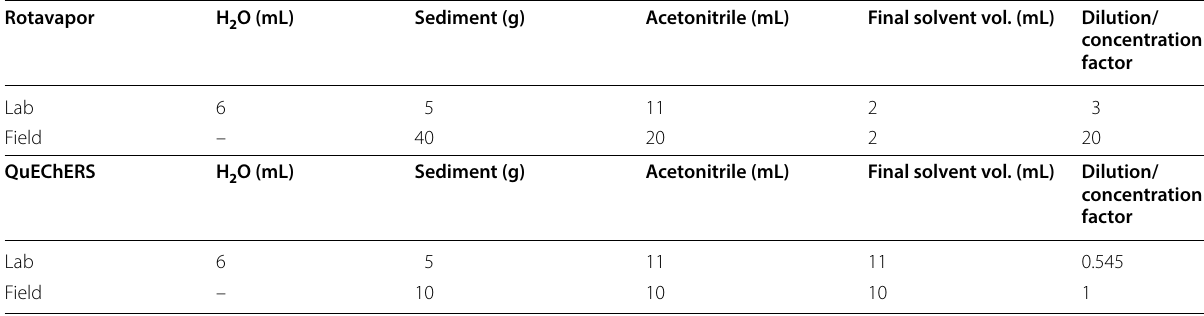
Table 1 Descriptions of sample and solvent volume and dilution/concentration used for rotavapor (RM) and QuEChERS (QM) based analysis